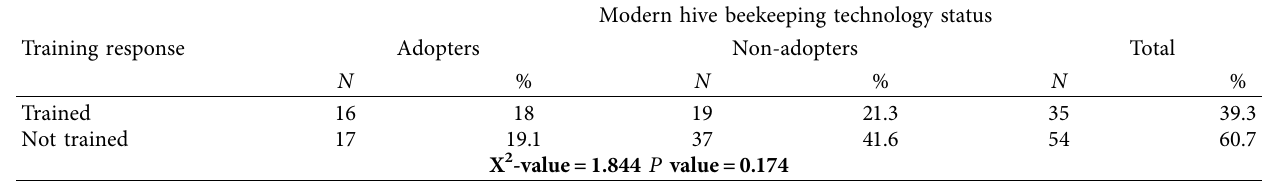
Table 11: Training by sampled